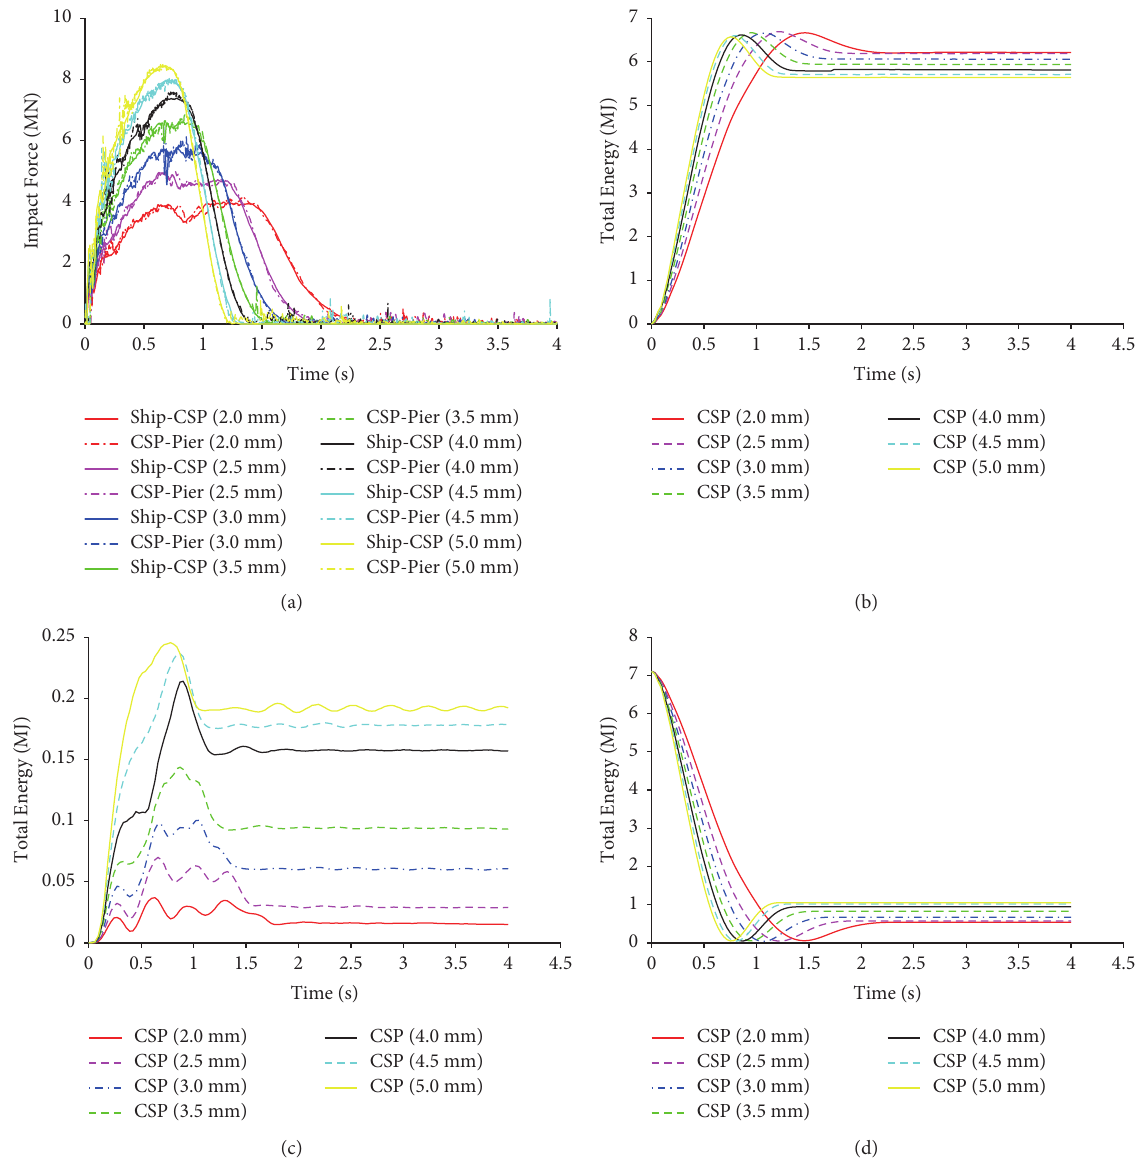
Figure 11: Time history curves of each case: (a) impact force, (b) total energy of CSP, (c) total energy of bridge piers, and (d) total energy of barge.